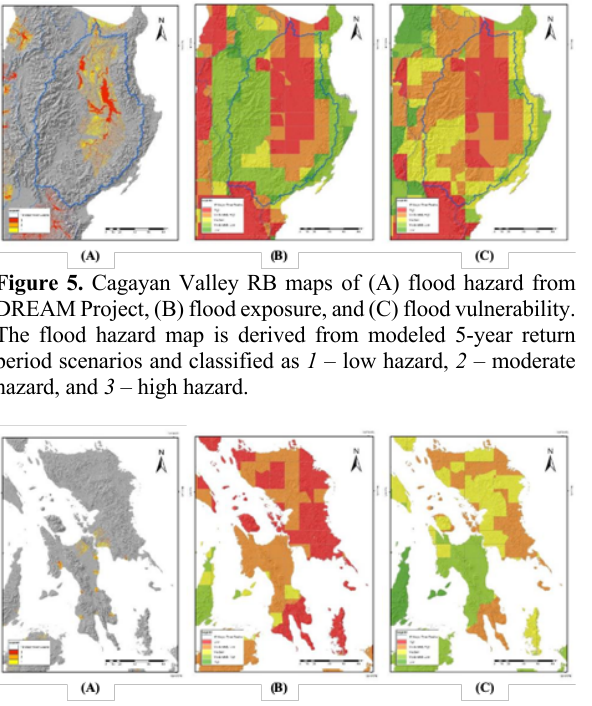
Figure 6. Maps of the Eastern Visayas Region of (A) flood hazard from Phil-LiDAR Program, (B) flood adaptive capacity, and (C) flood vulnerability. The flood hazard map is derived from modeled 5-year return period scenarios and classified as 1 – low hazard, 2 – moderate hazard, and 3 – high